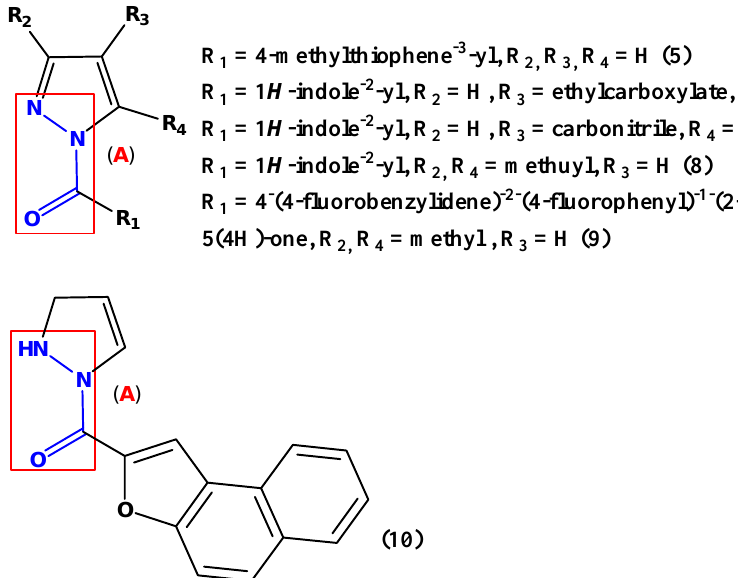
= 4-chlorophenyl, 1 = 4- substituted -benzyl or 1 , 1